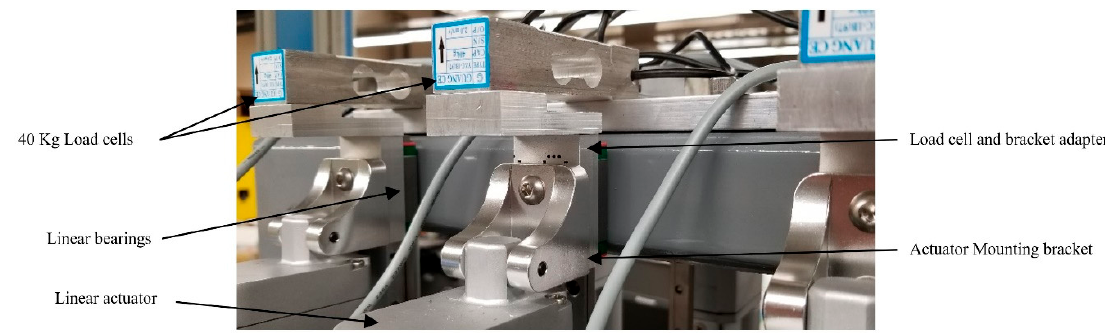
Figure 7. Linear actuator assembly.